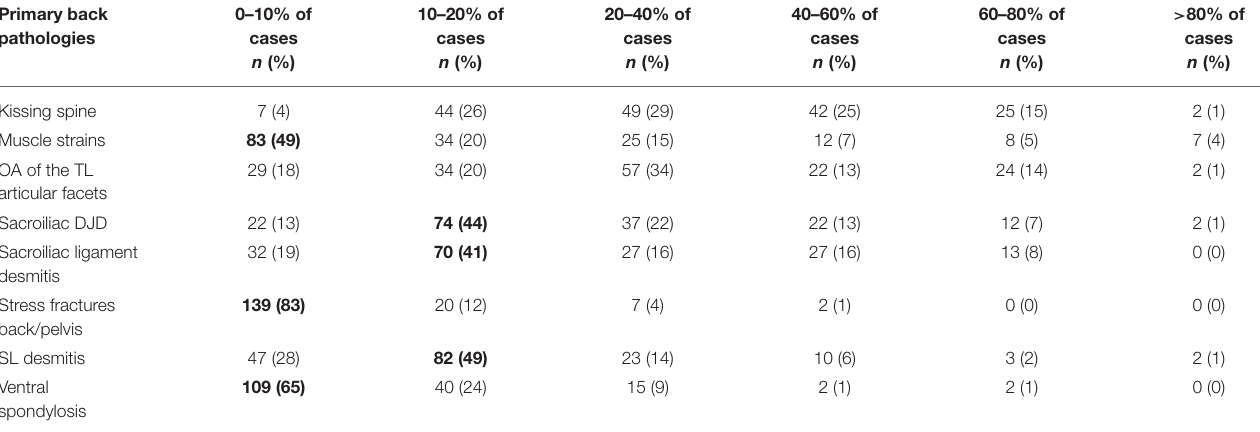
TABLE 5 | Primary back pathologies and corresponding frequencies identified in the case-load of horses with back-pain by 2016 survey respondents. Primary back